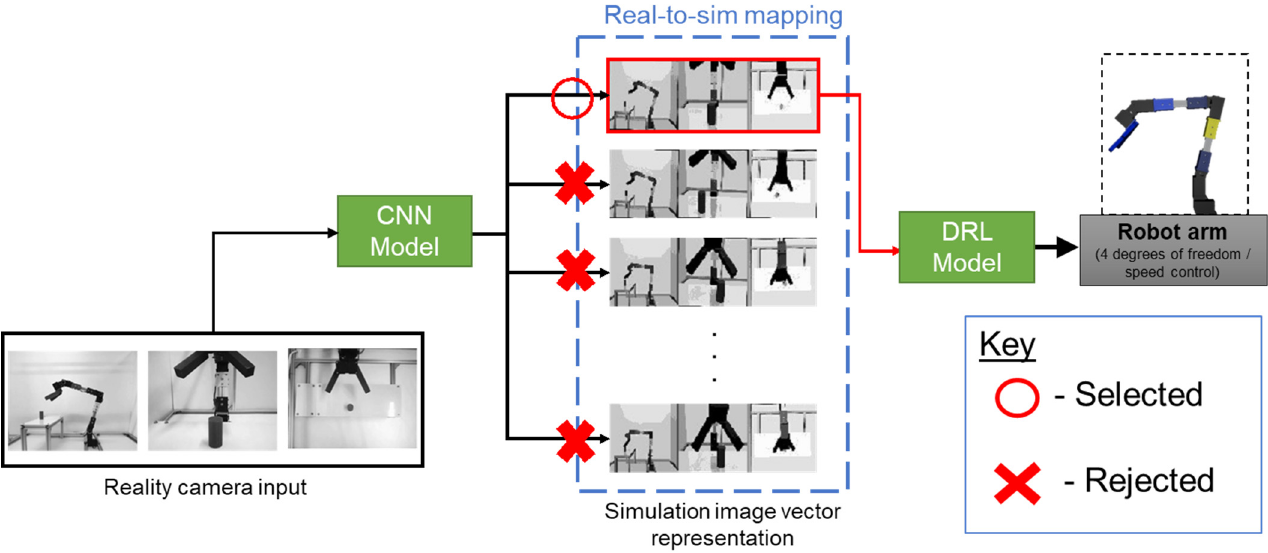
Figure 9. Proposed real–sim mapping model showing the selection of the best corresponding virtual image set from the real-world camera input.